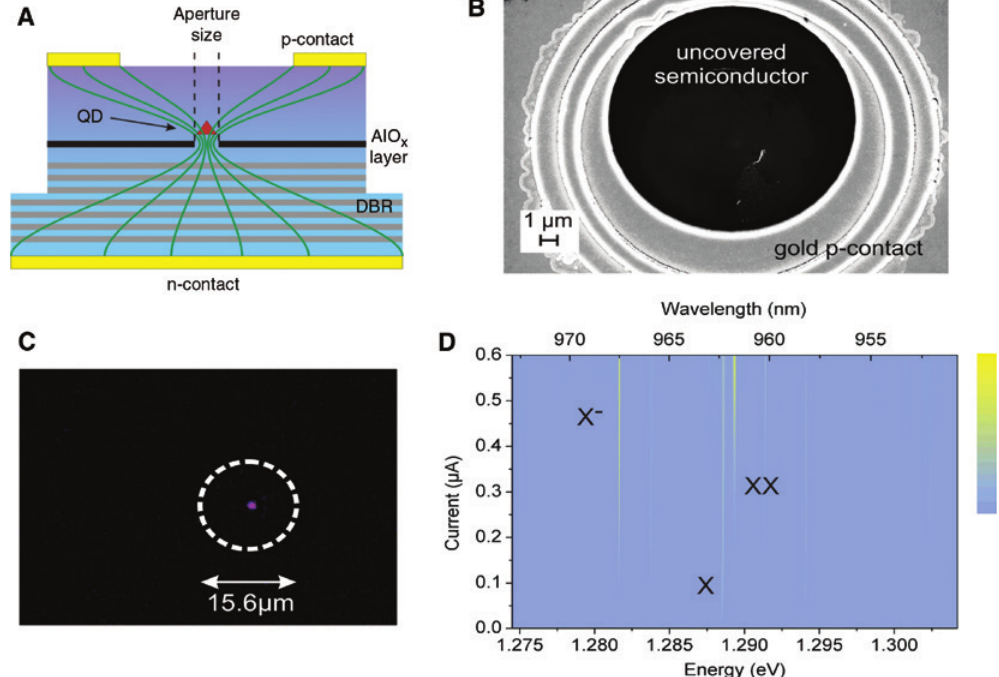
Figure 6: (A) Schematic cross-section of a single electrically driven q-bit emitter with one Bragg reflector showing the QD position, aperture size, and current flow, from Refs. [32–34]. (B) Scanning microscopy image of an electrically driven SPE. (C) Single q-bit emission from a single QD. (D) Spectra of a single exciton, a trion, and an excitonic molecule from the device shown in B as a function of current. With increasing current the single exciton emission saturates, from Refs. [32–34].